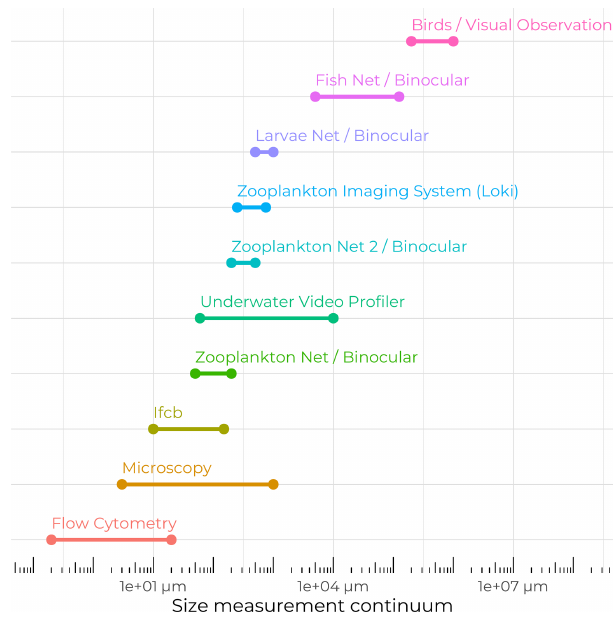
Figure 9. Schematic of the biological sampling size continuum across the various methods and tools used during the Green Edge